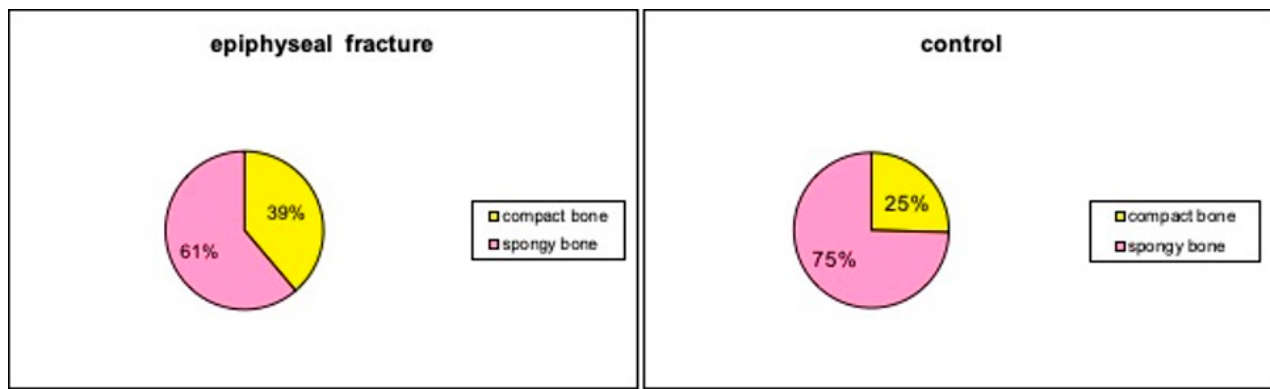
Figure 9. Microradiographies examination of fractured ( a ) and healthy ( b ) epiphysis show complete fracture healing although slight differences in shape and microscopic structures.